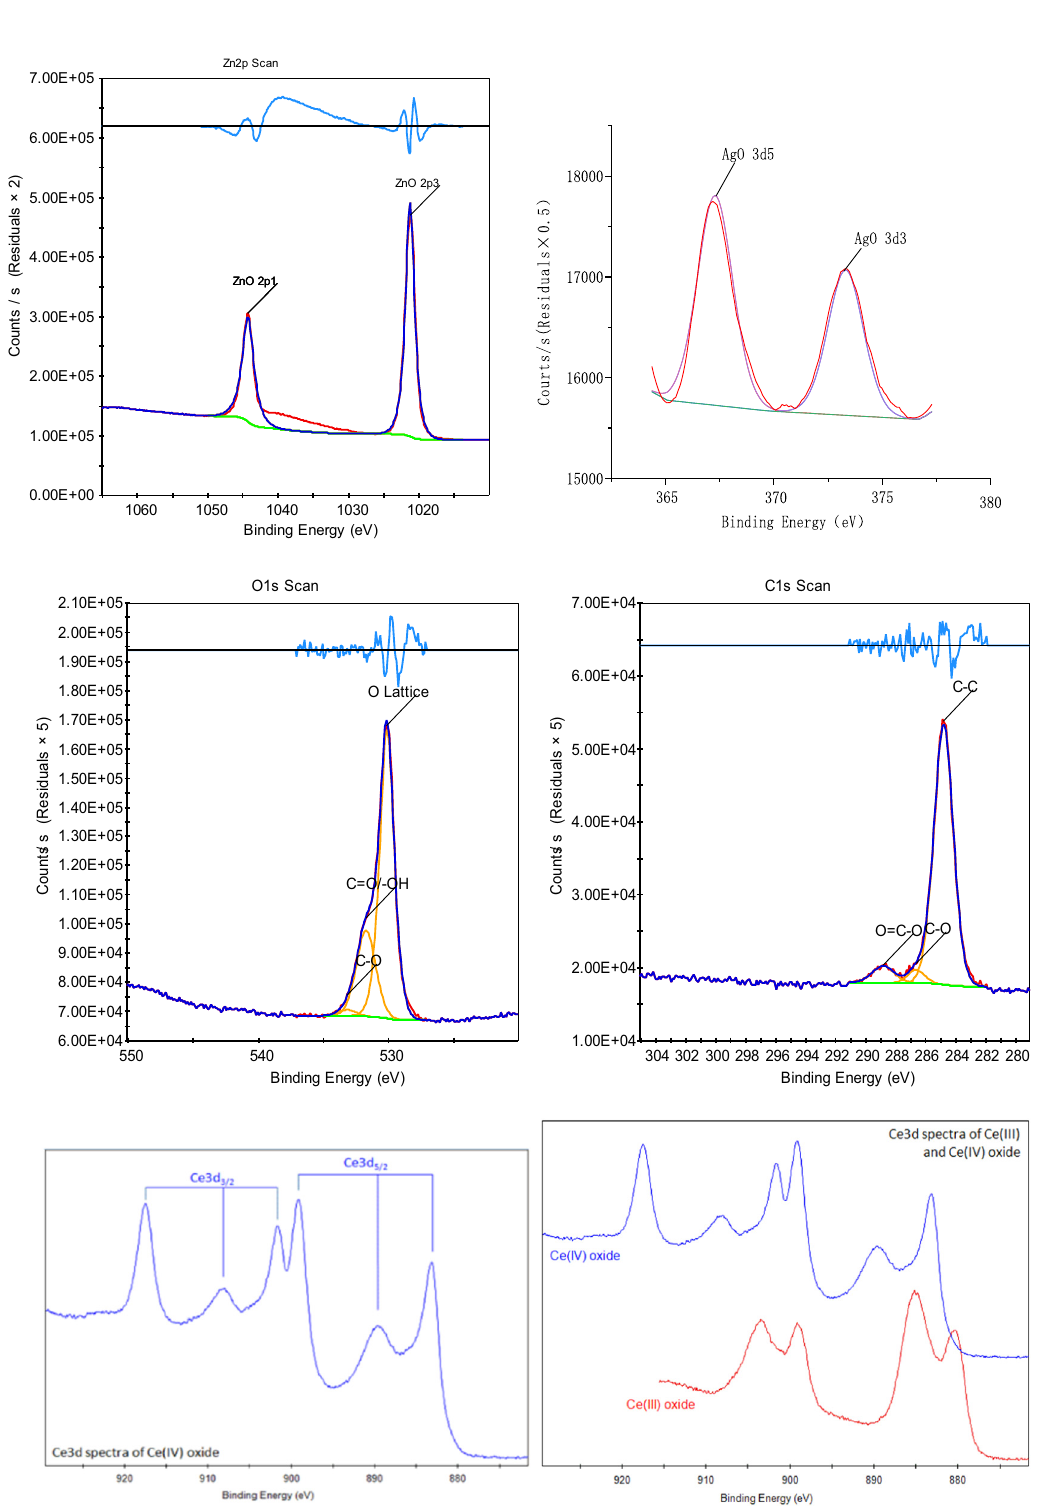
Figure 6: Full spectrum XPS analysis diagram of